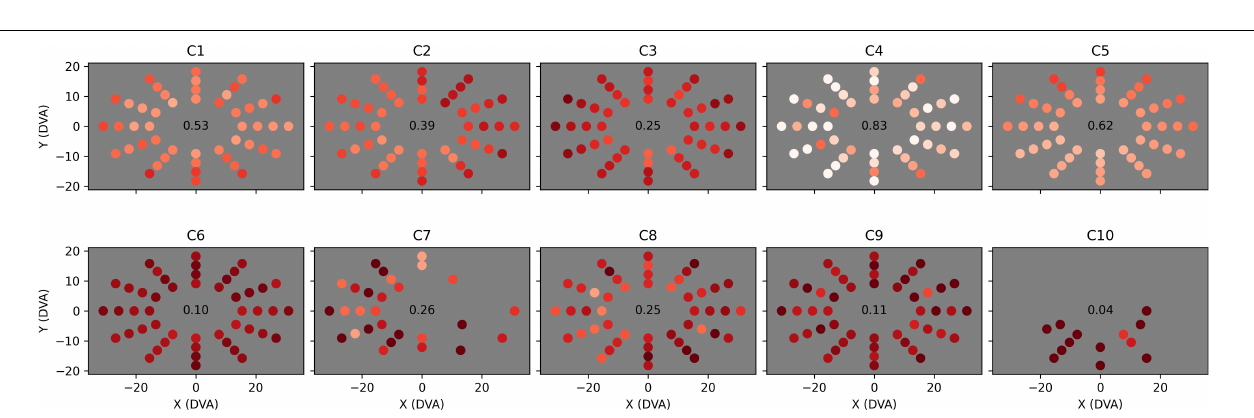
FIGURE 7 | Mean saccade latency across the visual field for each child. Each dot represents the Cartesian coordinates in degrees of visual arc of one of 48 tested locations. The dot’s color indicates mean saccade latency for all valid (i.e., completed) trials to that location, provided that at least three valid trials occurred, on a color map shared by all ten observers ranging from zero (white) to five (red) seconds. Locations at which less than three valid trials were completed are left empty (C7 and C10). Overall mean saccade latency is shown in the center of each plot.